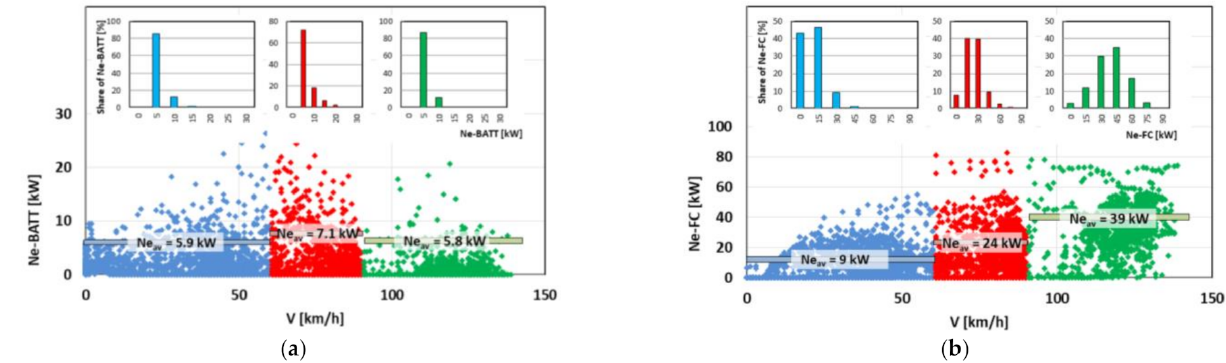
Figure 6. Powertrain usage conditions: ( a ) battery, ( b ) fuel cell; with a specific subdivision of the test phases.